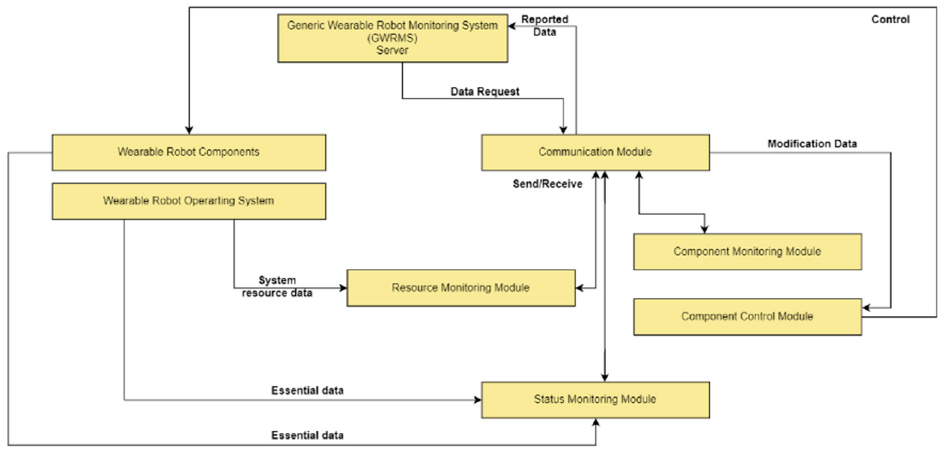
Figure 2. Data flow diagram showing the interactions between robot components and modules of the GWRMS.